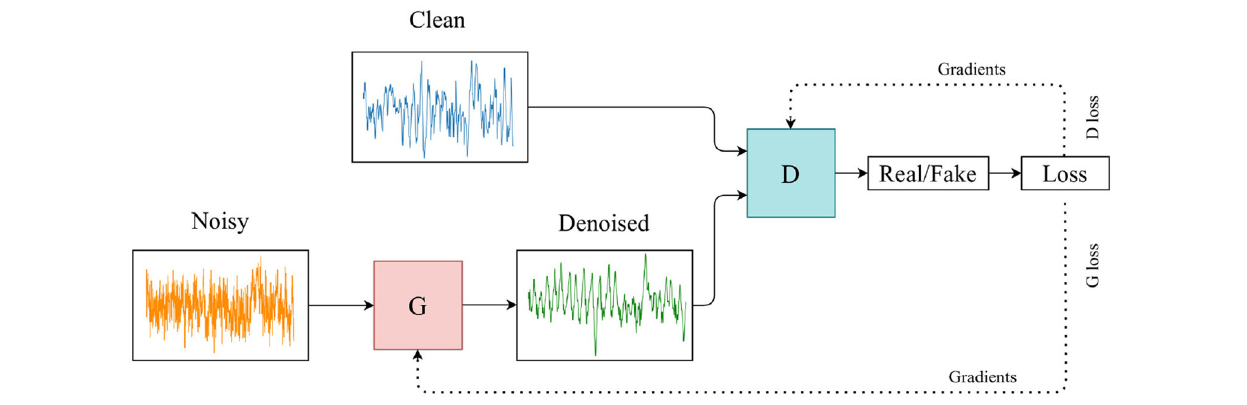
FIGURE 2 | Architecture of the GAN. Noisy EEG to clean